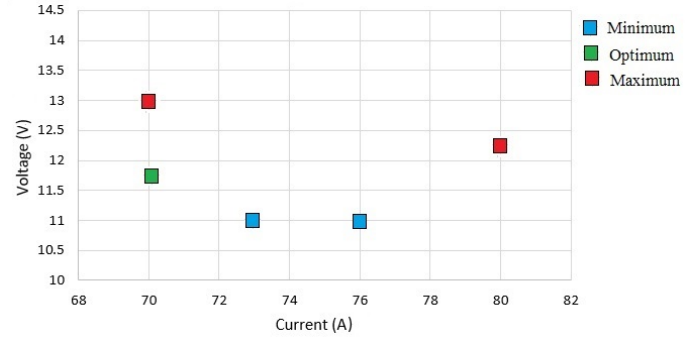
Figure 15. The minimum, optimum, and maximum values of the residual stress and distor- tion